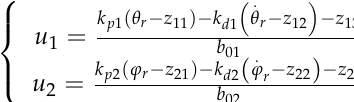
Table 2. Parafoil model parameters. m